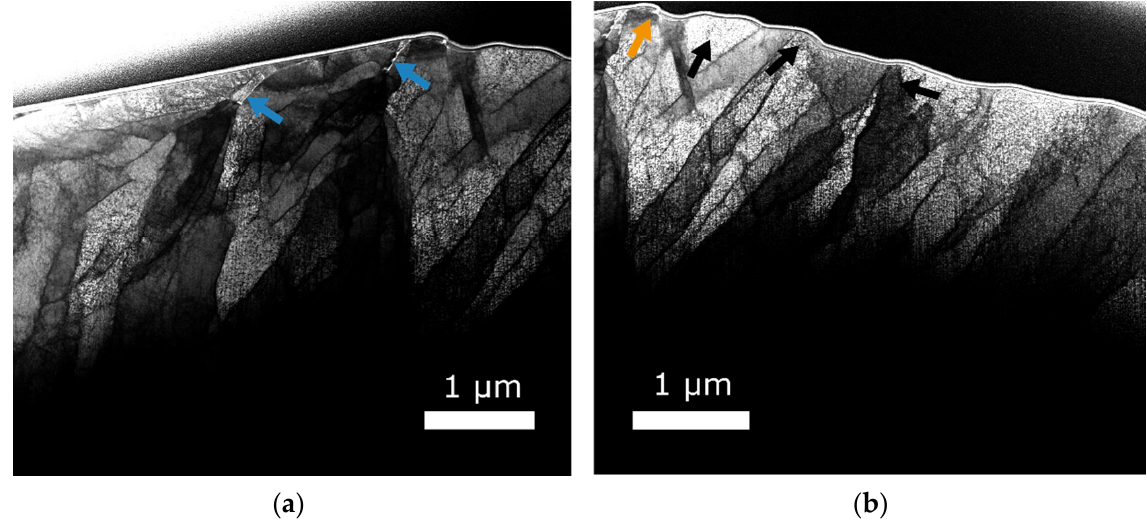
Figure 7. Bright field T-SEM images (30 kV, 0.1 nA) of a foil prepared from the end of the wear track shown in Figure 6 (black rectangle). Sliding direction from left to right. Foils were taken along the sliding direction. ( a ) Part of the foil showing the end of the wear track. The ruby ball flattened the surface. The blue arrows indicate the white lines originating from folding of two former surfaces. ( b ) Image of the foil taken from the area directly in front of the wear track. The black arrows mark the grains that formed protrusions. The yellow arrow indicates the development of a fold.